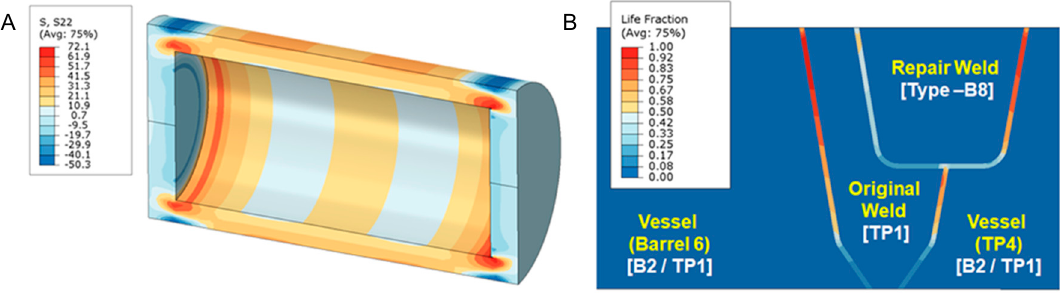
Figure 16. Evaluation of vessel test behavior using finite element analysis coupled with physically-informed constitutive models for creep damage initiation and crack growth, ( A ) showing local stress concentrations at the end caps and ( B ) showing damage estimates for the weldments.